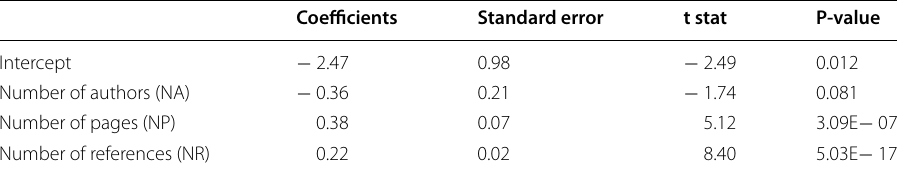
Table 10 Result of t-test for the effect of the number of publications in all and highly cited